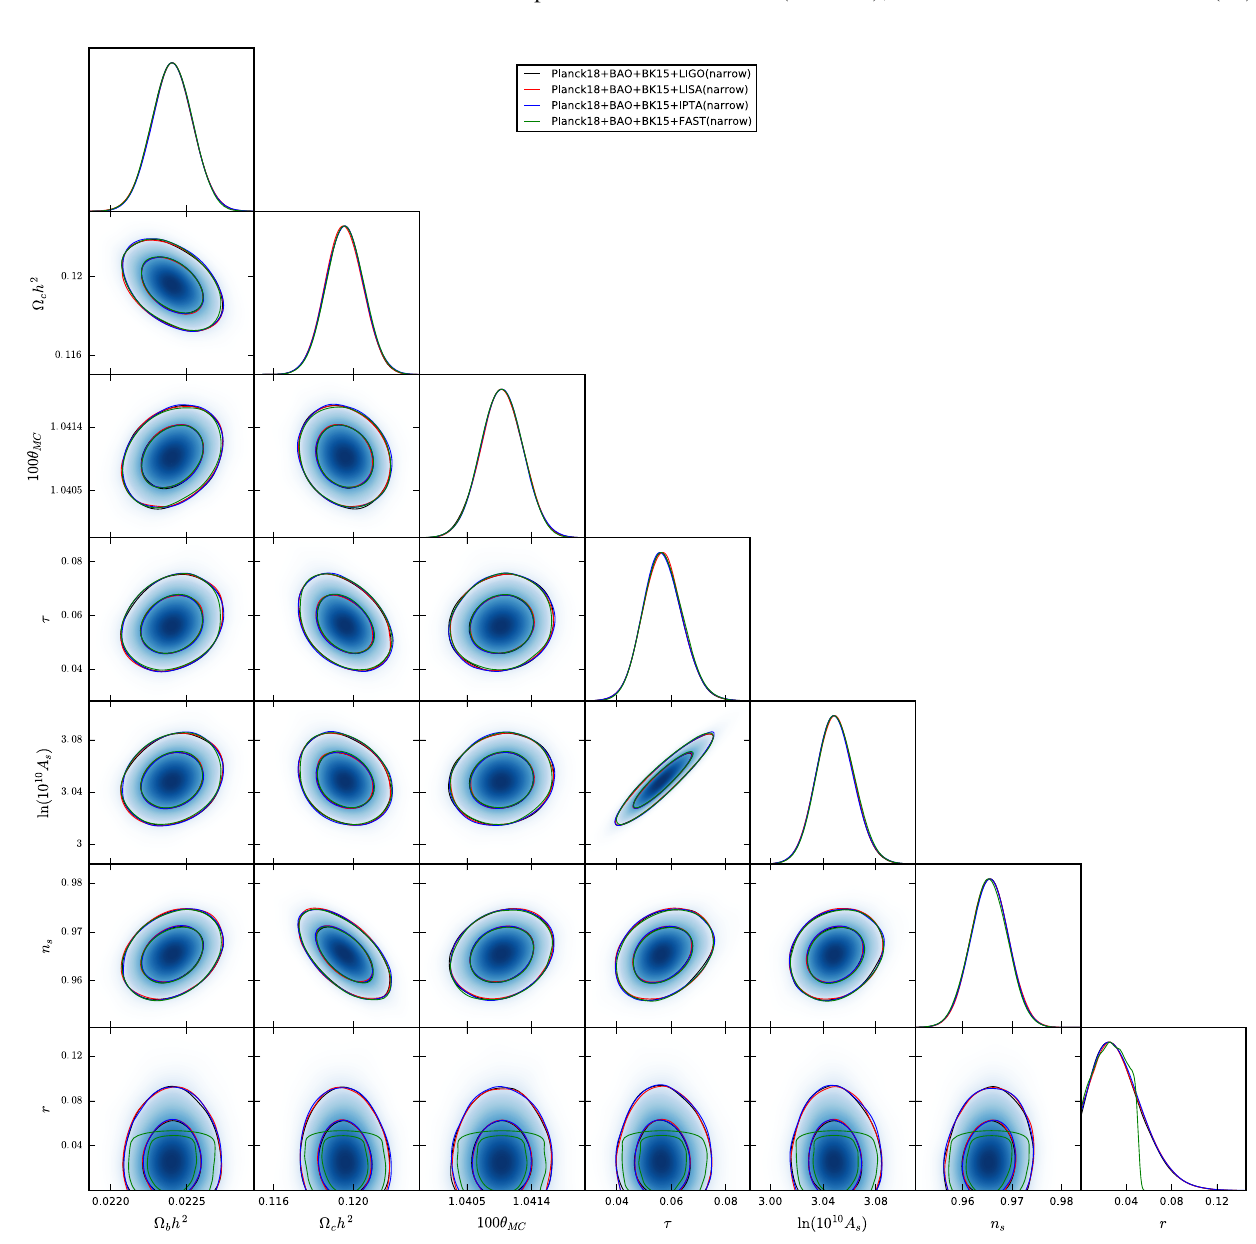
Fig. 5 The contour plots and the likelihood distributions for the cosmological parameters in the (cid:2) CDM+ r model at the 68% and 95% CL from the combinationsofPlanck18+BAO+BK15+LIGO n ,Planck18+BAO+BK15+LISA n ,Planck18+BAO+BK15+IPTA n ,Planck18+BAO+BK15+FAST n